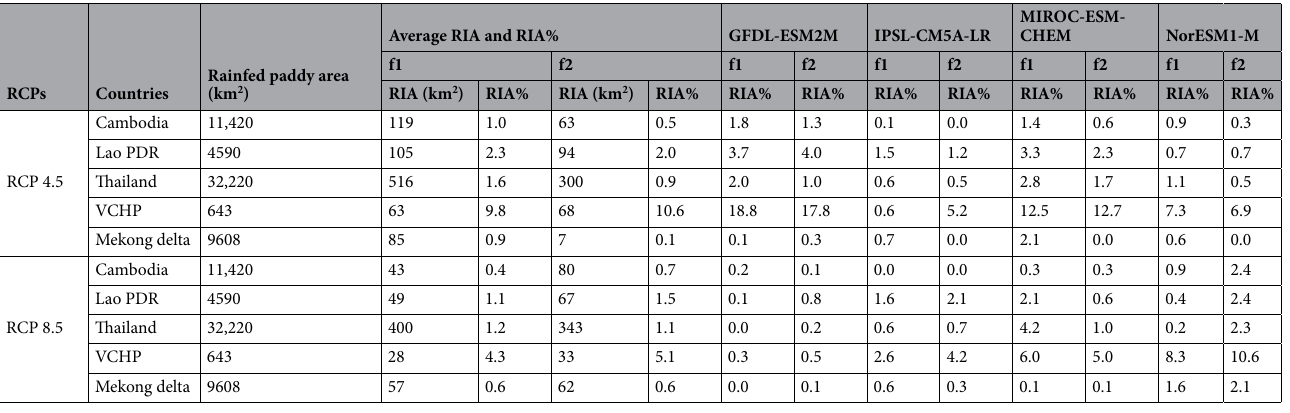
Table 3. Required irrigation areas (RIA) and the percentage (RIA%) for the future periods. f1: 2020–2059, f2: 2060–2099. RIA Required irrigation area (km 2 ), RIA% Required irrigation area (%), VCHP Vietnam Central High